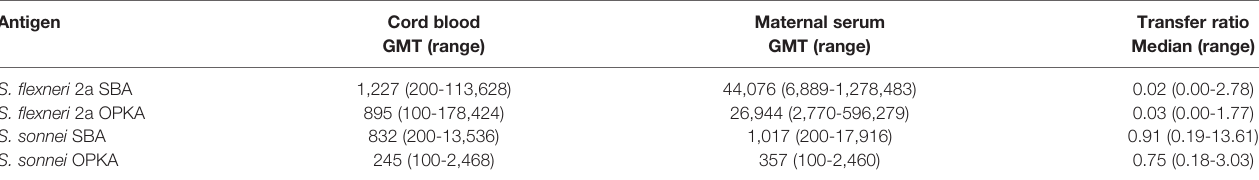
TABLE 3 | Shigella functional antibody (SBA and OPKA) titers. Antigen Cord blood Maternal